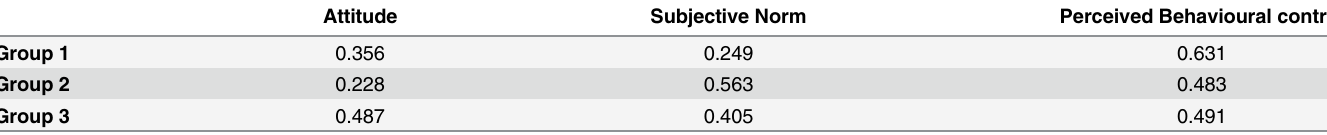
Table 3. Zero-order correlation coefficients between TPB components and behavioural intentions.